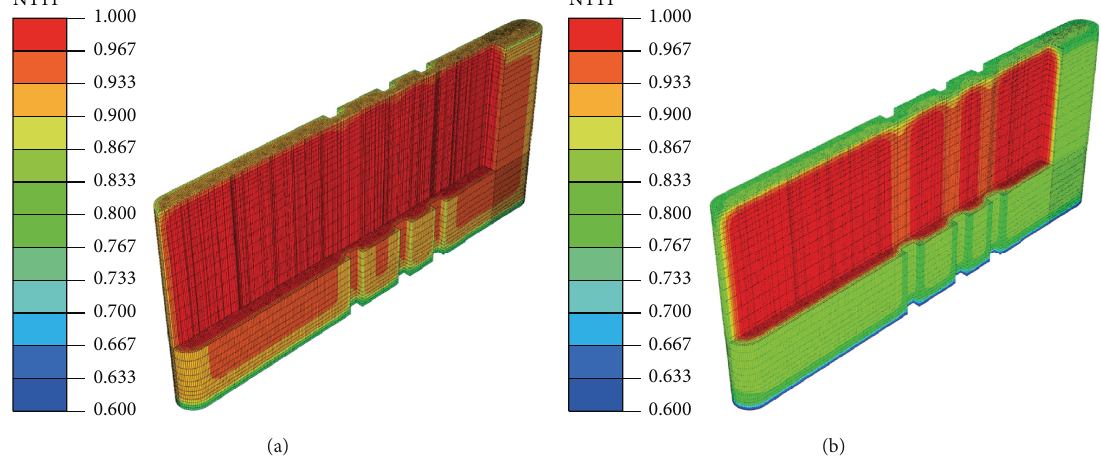
Figure 8: Relative humidity distributions at 100 hours (a) and 672 hours (b) after